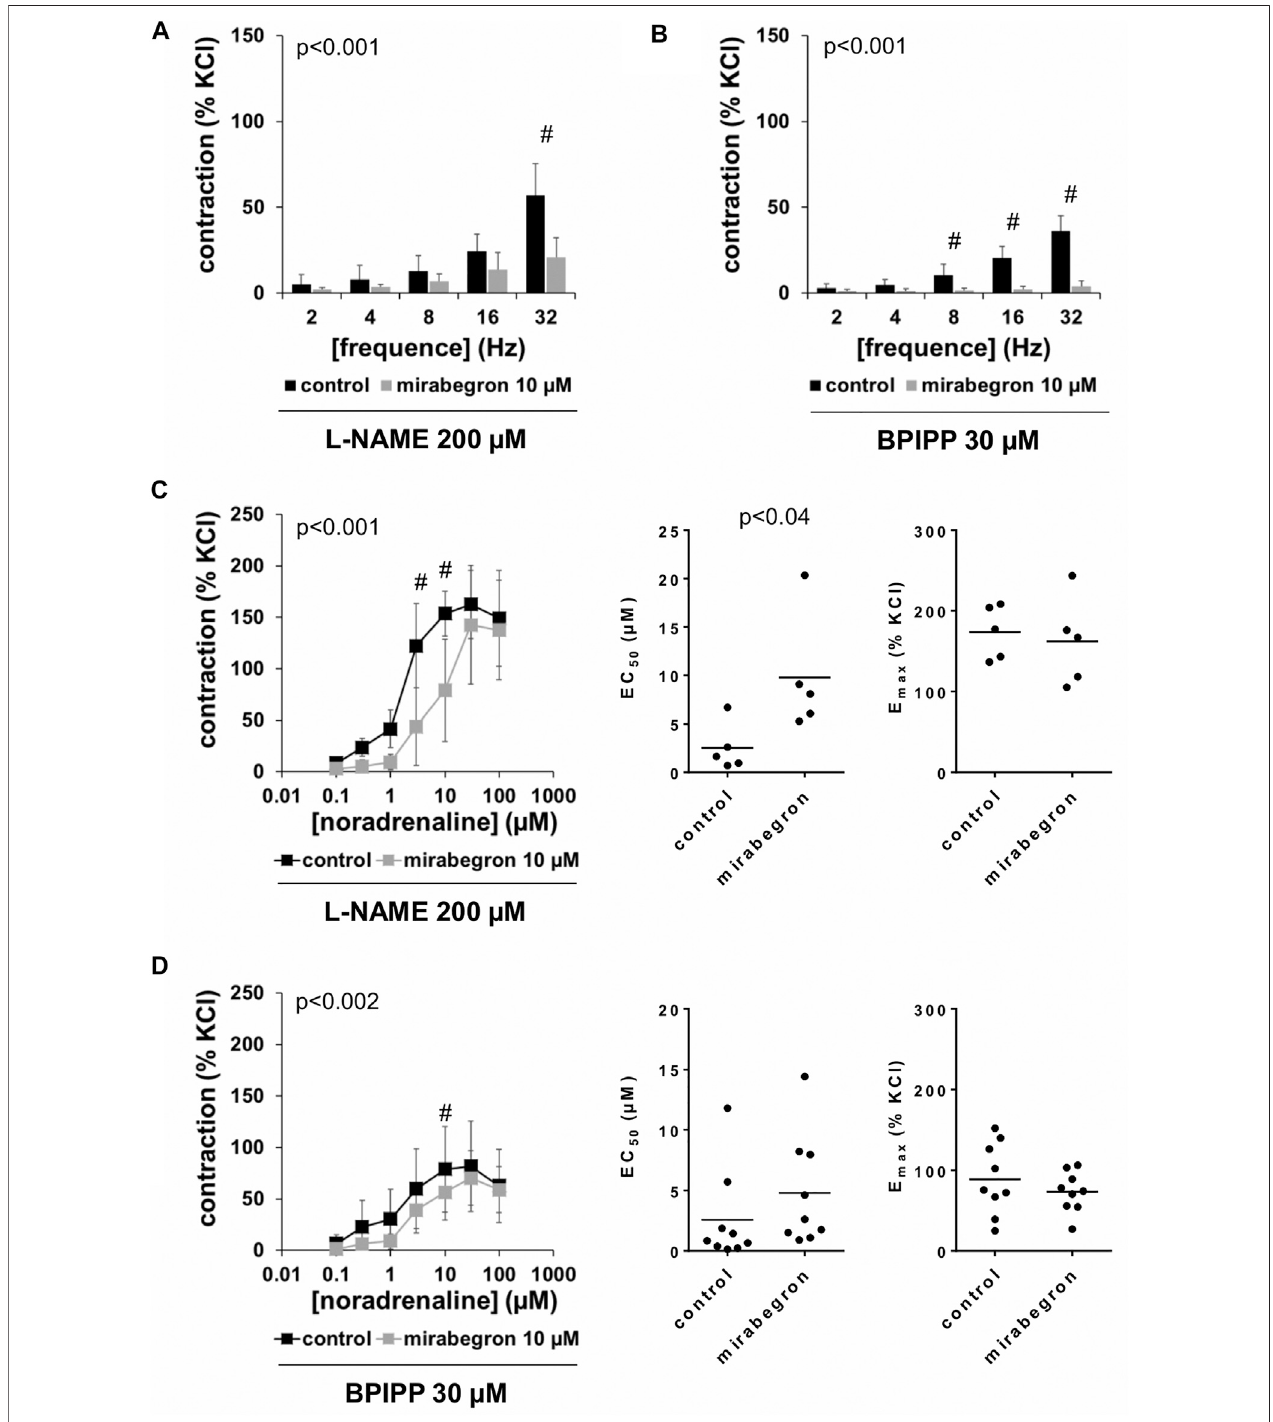
FIGURE 7 | Effects of mirabegron on EFS- and noradrenaline-induced contractions of human prostate tissues in the presence of L -NAME or BPIPP. Contractions of prostate tissues from the periurethral zone were induced by EFS (A, B) or noradrenaline (C, D) in an organ bath, 50 min after adddition ofeither L -NAME (200 µM) (A, C) or BPIPP (30 µM) (B, D) to all tissues and 30 min after addition of mirabegron (10 µM) or an equivalent amount of DMSO (controls), which was used as solvent for mirabegron.Shown aredatafrom n (cid:1) 5patientsineach diagramin (A – C) and from n (cid:1) 9patients in (D) ,whicharemeans ± SDinfrequencyresponse curves (# p < 0.05 for control vs. mirabegron by two-way ANOVA, and p values for whole groups in inserts from 1-way ANOVA).